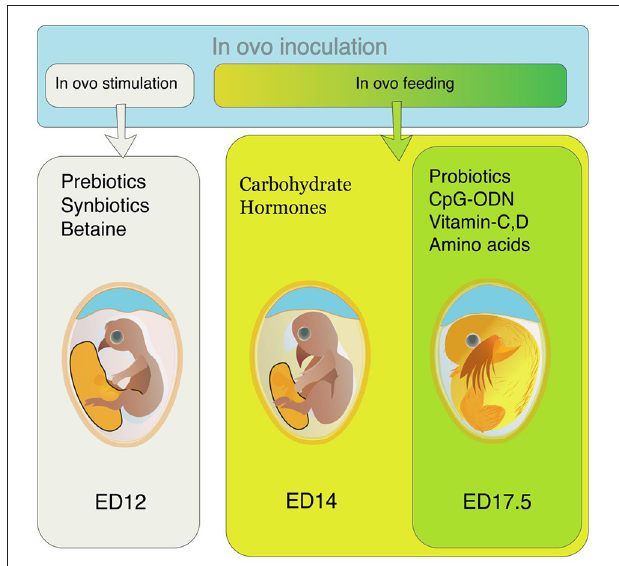
FIGURE 1 | Preferred time of in ovo inoculation for different bioactive compounds. For in ovo stimulation, supplements like prebiotics, synbiotics, and betaine are inoculated on ED 12. For in ovo feeding, the preferable time of supplementation is either ED14 (for carbohydrates, hormones, and alike compounds) or ED 17.5 (for probiotics, CpG-ODN, vitamins, amino acids, etc.).